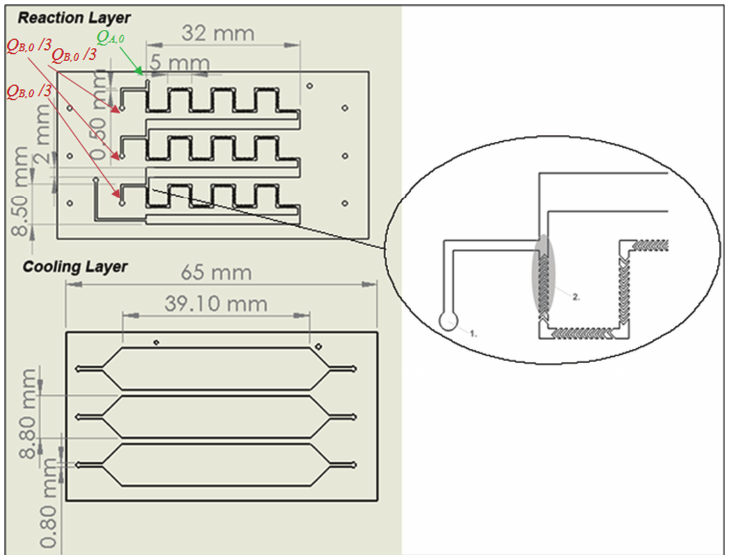
Figure 7 Scheme of the two main layers constituting the multi-injection reactor: the reaction layer (top) contains the herringbone mixing structures, and the cooling layer (bottom) is made up of three large cooling channels covering each one set of a mixing and residence time channel of the reaction layer.